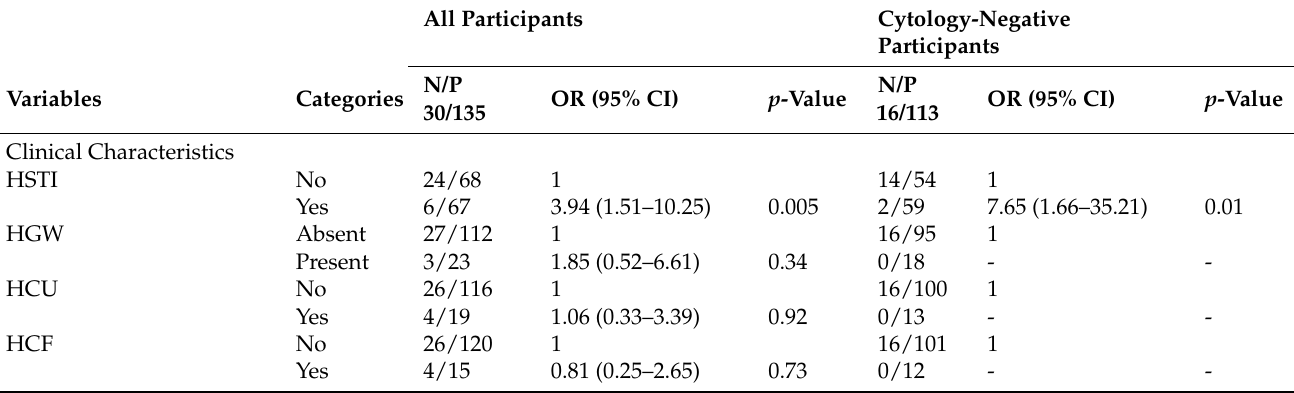
Table 3. Odds ratios of HPV positivity according to clinical characteristics